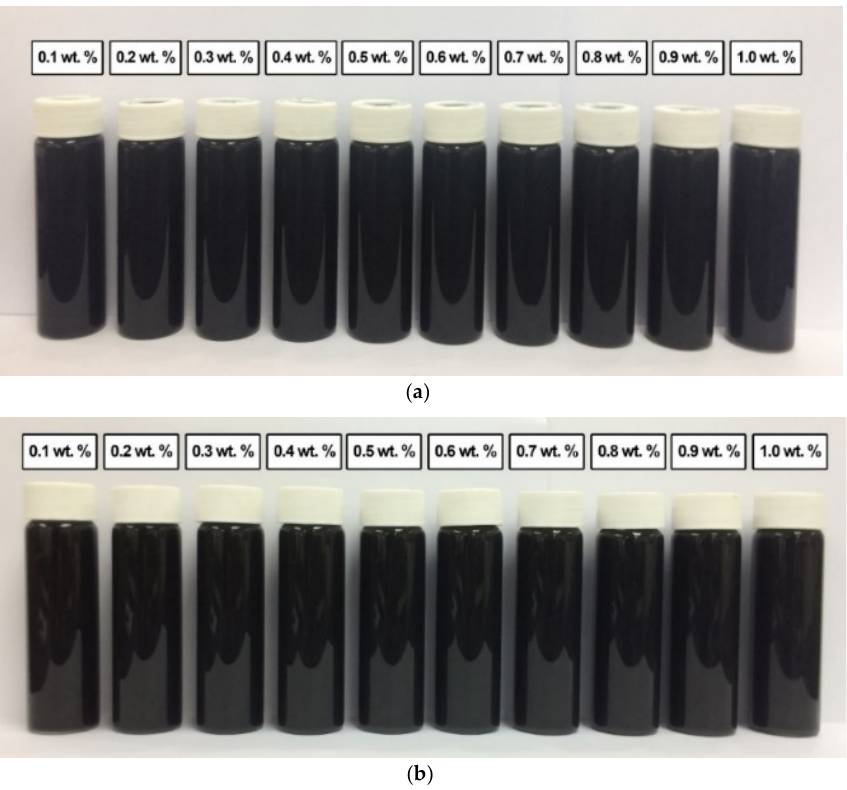
Figure 13. The various surface-oxidised CNF-based nanofluids with the addition of PVP after ( a ) 0.5 h and ( b ) 100 h of the homogenisation and sonication process.